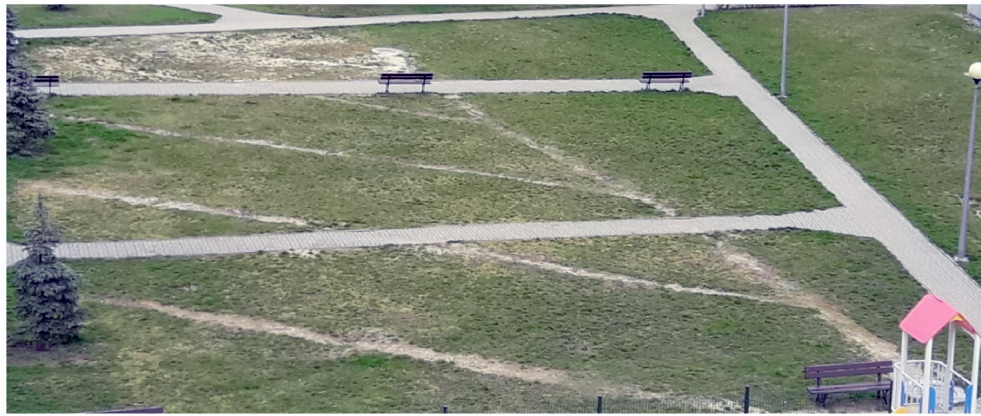
Figure 1. Example of the effects of implementing classical land drainage